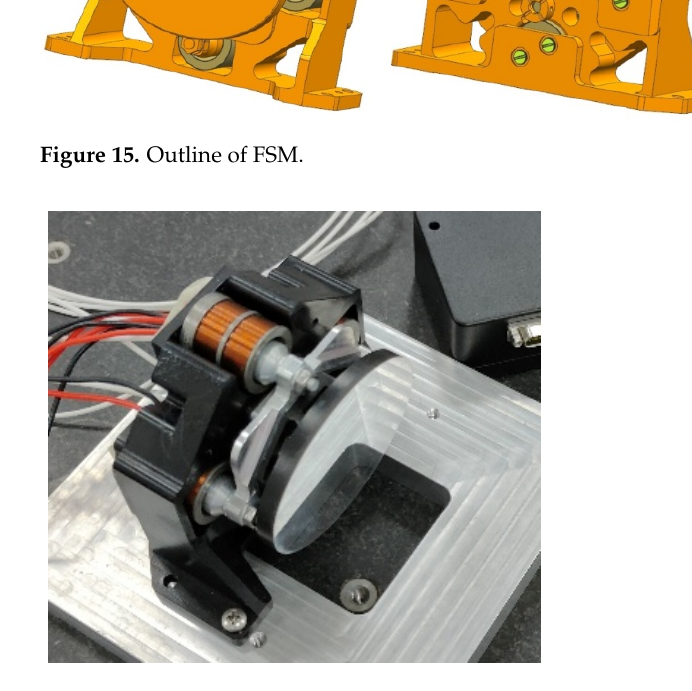
Figure 16. Physical object of FSM.